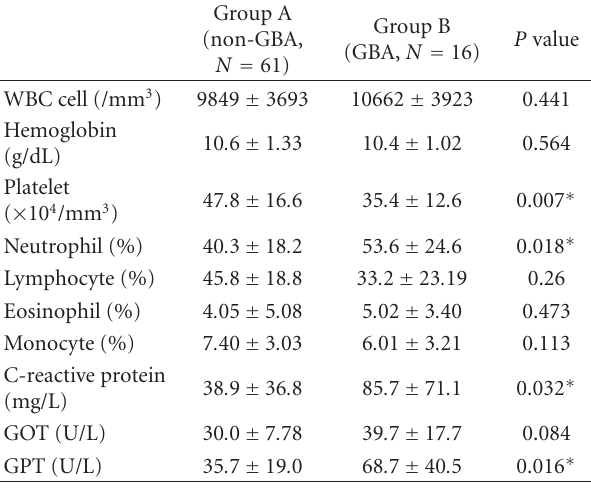
Table 3: Comparison of lab data between gallbladder abnormality (GBA) and non-GBA in Kawasaki disease before IVIG therapy.